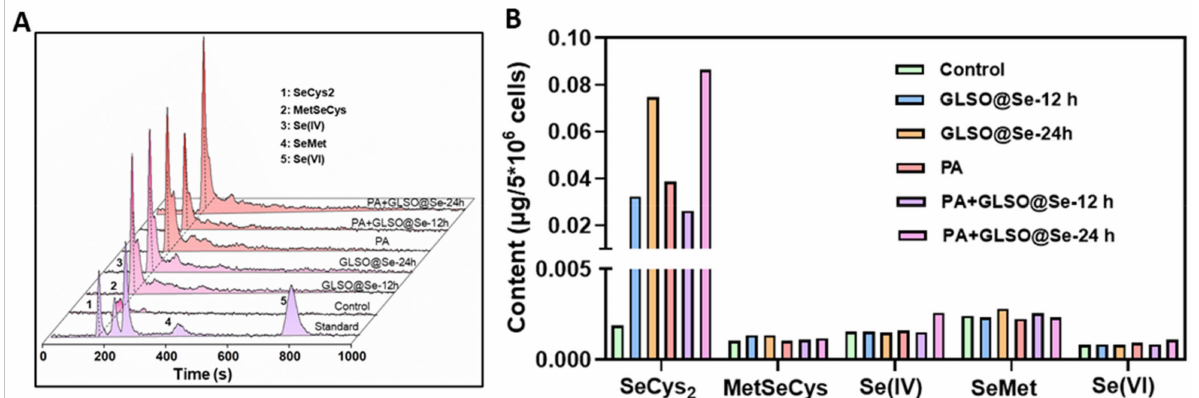
Figure 7. GLSO@SeNP metabolism in INS-1E cells. ( A ) Selenium metabolites, including SeCys2, MetSeCys, Se(IV), SeMet, and Se(VI), in INS-1E cells after treatment for 12 and 24 h. ( B ) Quantitative analysis of selenium